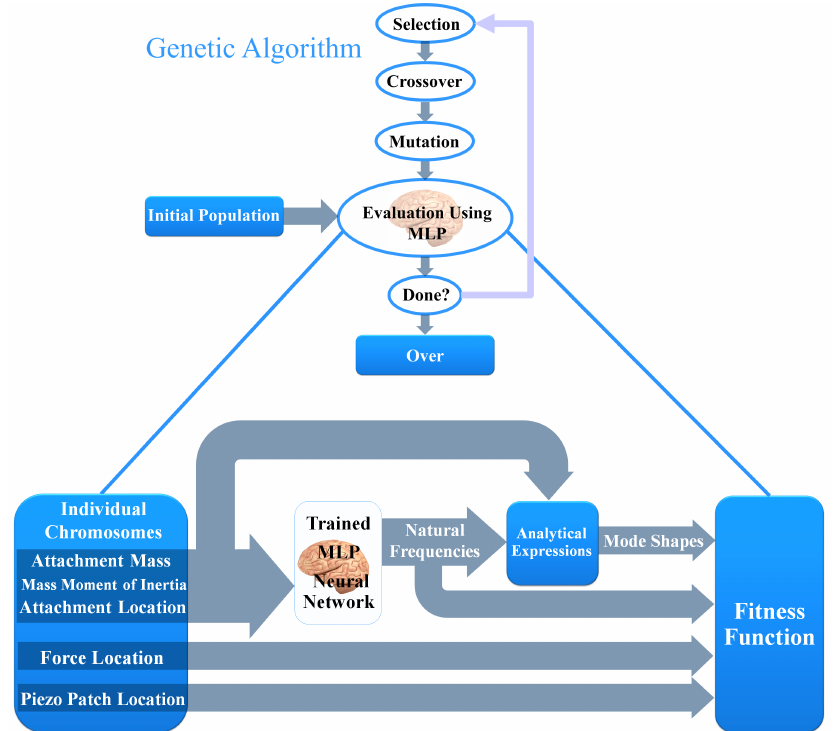
Figure 4. Diagram of neural network based genetic algorithm